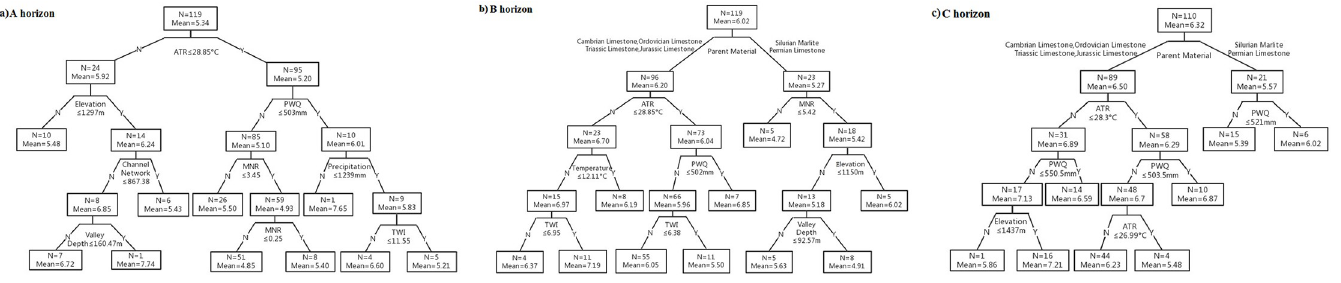
PLOS ONE | https://doi.org/10.1371/journal.pone.0218563 June 19,